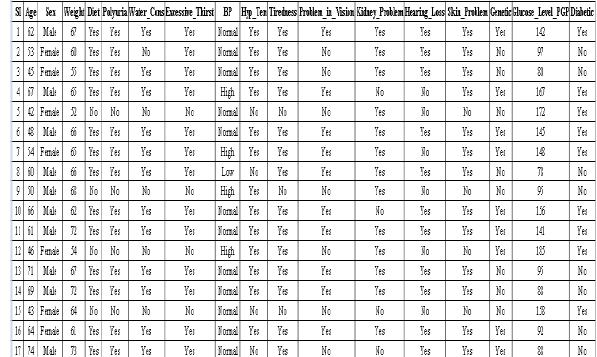
Table 12. Sample dataset of diabetic skin problem patients.